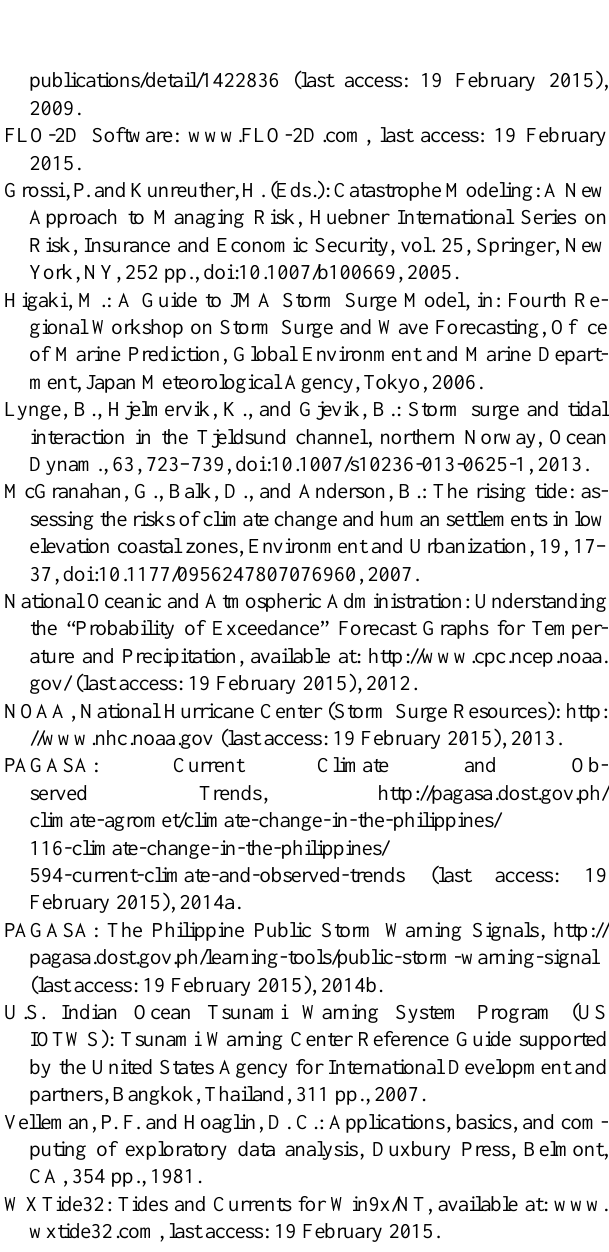
Figure 13. Flood depth values for the selected points of